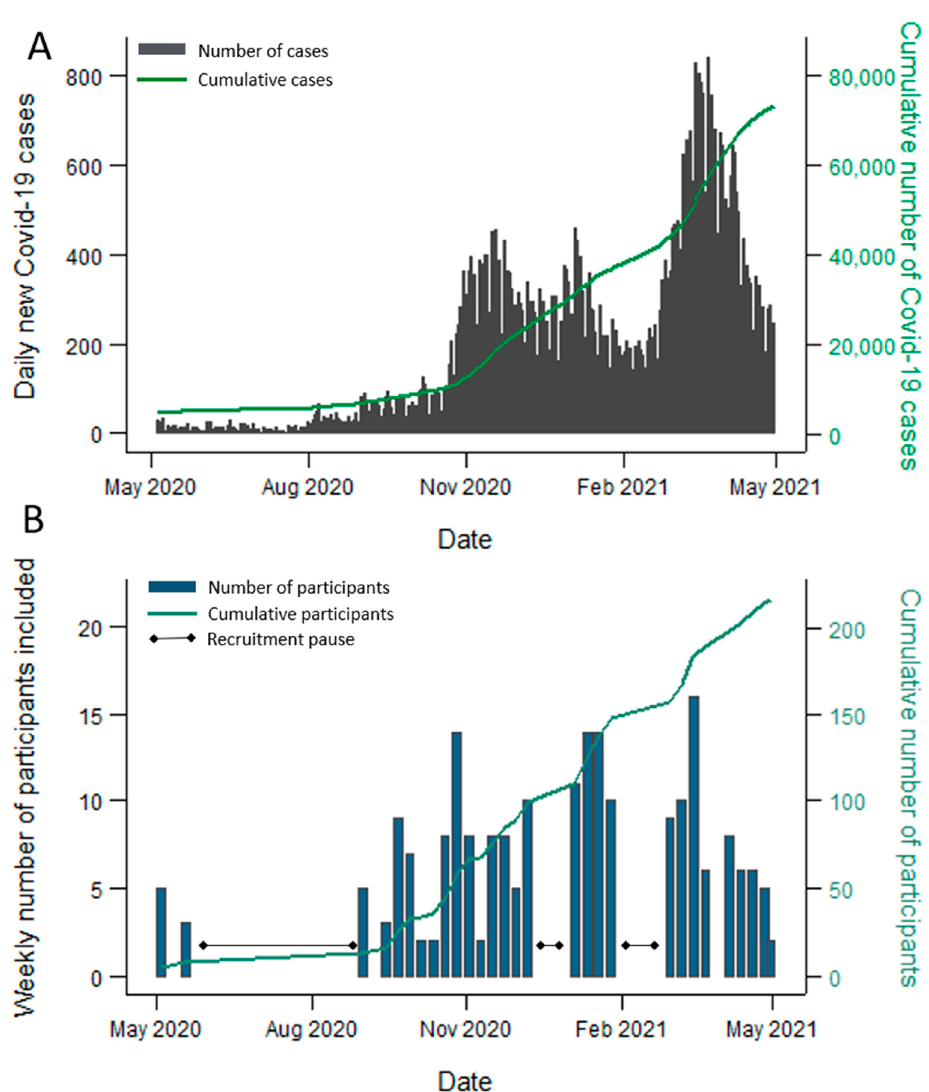
Figure 1. The course of the COVID-19 pandemic in Oslo/Viken, Norway, and the number of participants included in the study from 1 May 2020 to 30 April 2021. ( A ) The number of all reported laboratory confirmed COVID-19 cases in Oslo/Viken, Norway, during the study recruitment period. Participating households were recruited from these two counties. The daily number of cases is shown in grey, while the cumulative number of cases is shown in green. Source: Norwegian Surveillance System for Communicable Diseases (MSIS). ( B ) The number of included participants during the study recruitment period. The weekly number of participants included is shown in blue, while the cumulative number is shown in green. Three recruitment pauses are indicated.